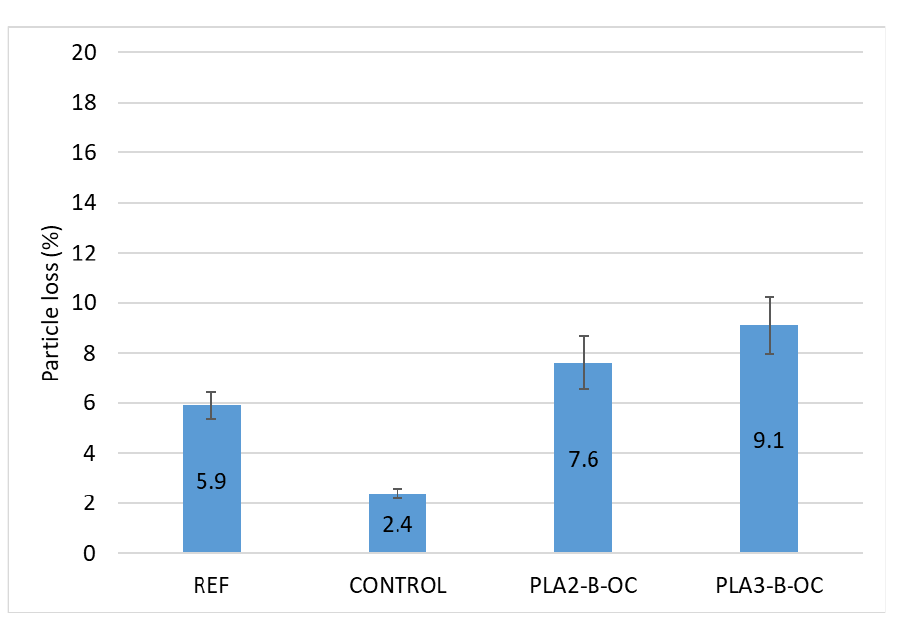
Figure 10. Mean values of Cantabro particle loss test.